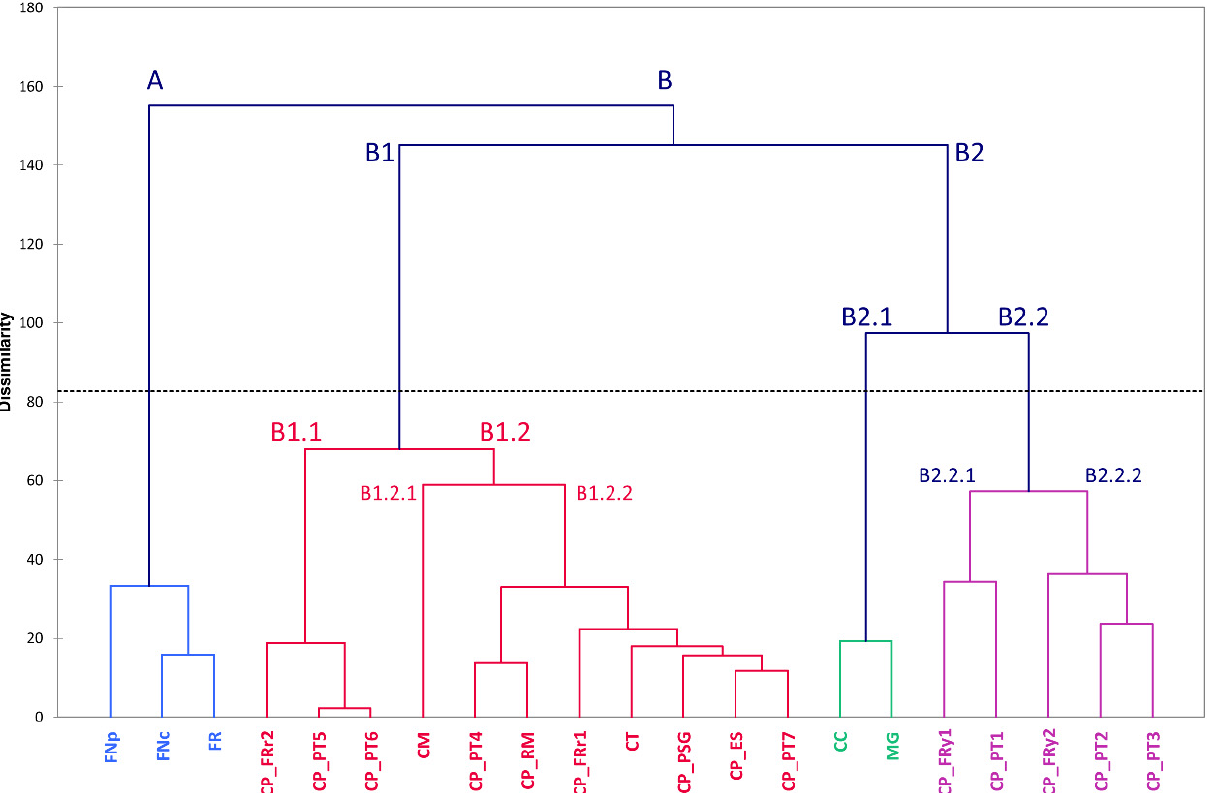
Figure 3. Figure 3. Cluster analysis (Ward coefficient) based on 52 phenotypic traits evaluated on 21 pepper accessions.